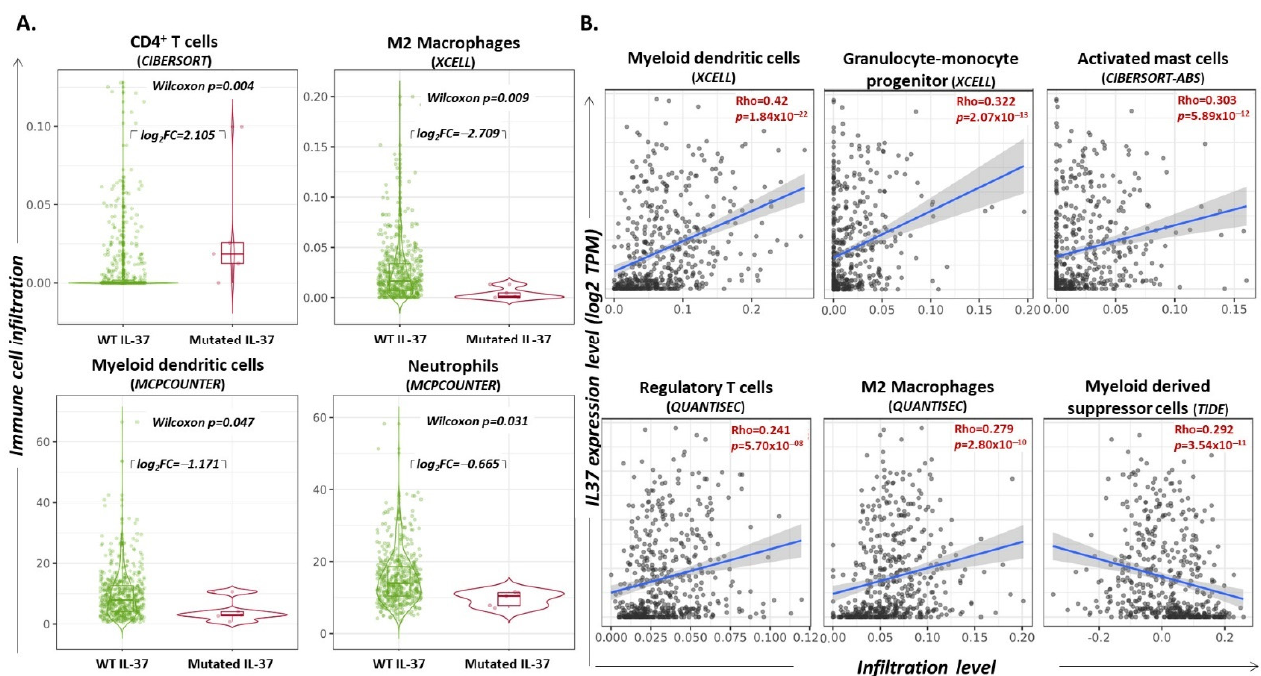
Figure 5. ( Α ) Violin plots depicting the distribution of infiltrated T cells, M2 macrophages, myeloid dendritic cells, and neutrophils in LUAD tumors without versus with mutation on IL-37 . Wilcoxon p -values and log 2 (fold-changes, FC) are reported. ( Β ) Scatter plot diagrams depicting the linear association between levels of IL-37 gene expression (log 2 TPM; y-axis) and infiltration of the tumor by certain cell subsets (x-axis). Spearman’s Rho and p -values are reported. Data were filtered for tumor purity. Graphs were exported from http://timer.cistrome.org/ [36] (accessed on 1 October 2022). 3.9. IL37 Expression Levels Correlate with Infiltration Levels of Certain Immune Cell Subsets